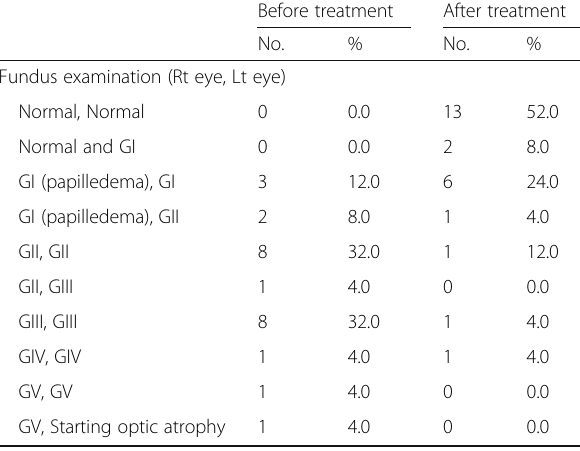
Table 1 Distribution of the studied cases according to fundus